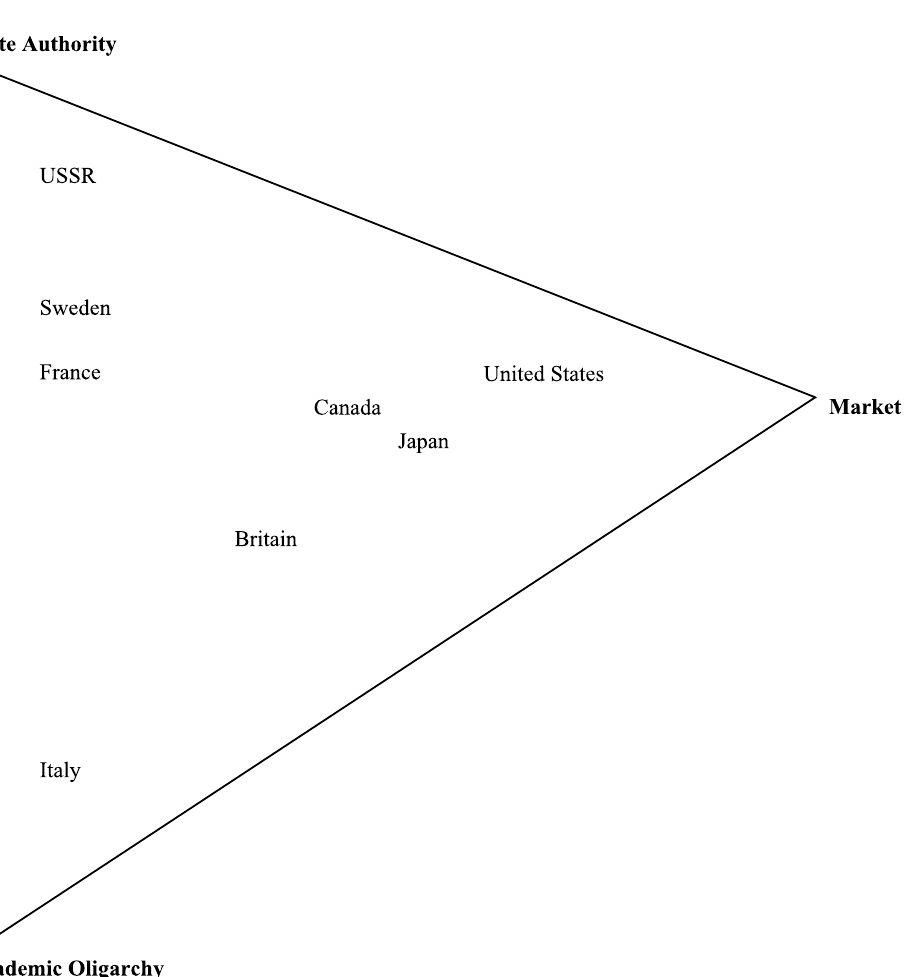
Figure 1. The triangle of co-ordination (Clark 1983,